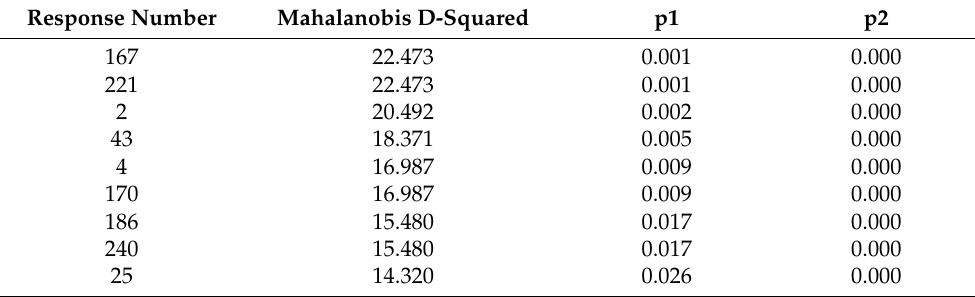
Table 2. Observations identified as